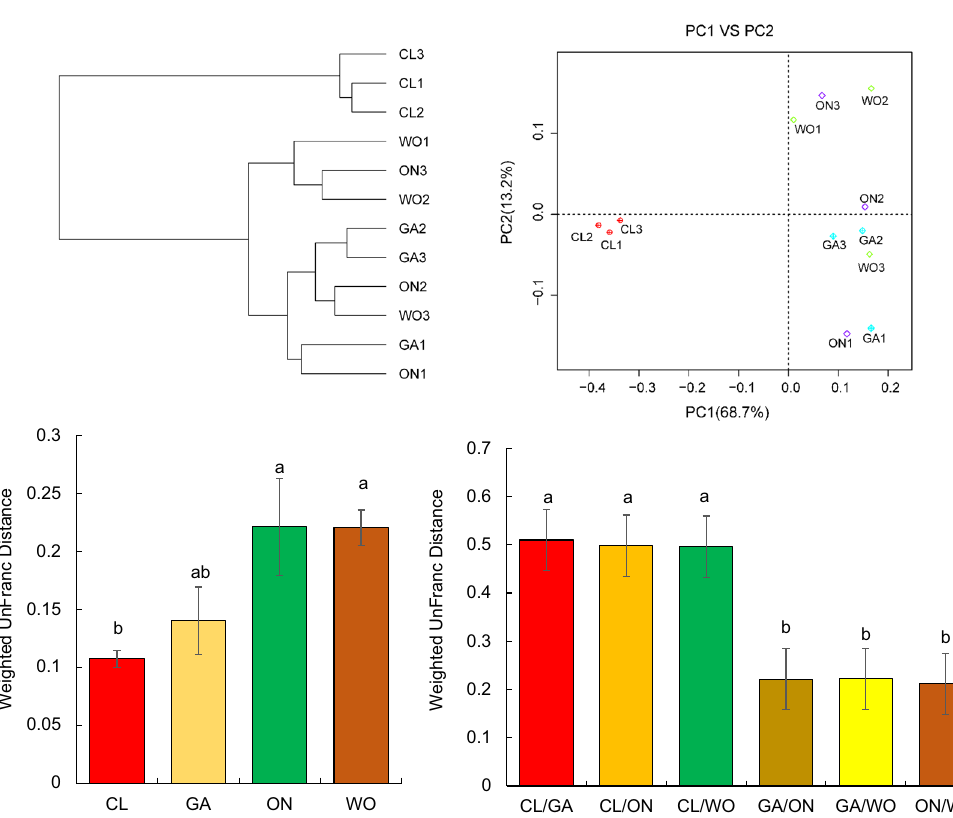
Figure 6. The endophytic bacterial profile of the four Allium species. Hierarchical cluster tree ( A ) and principal coordinate analysis (PCA) ( B ) of different microbiota in different samples based on weighted UniFrac distances. Comparison of within ( C ) and between ( D ) group distances for the Allium species. CL: Chinese leek; WO: Welsh onion; GA: Garlic; ON: onion.